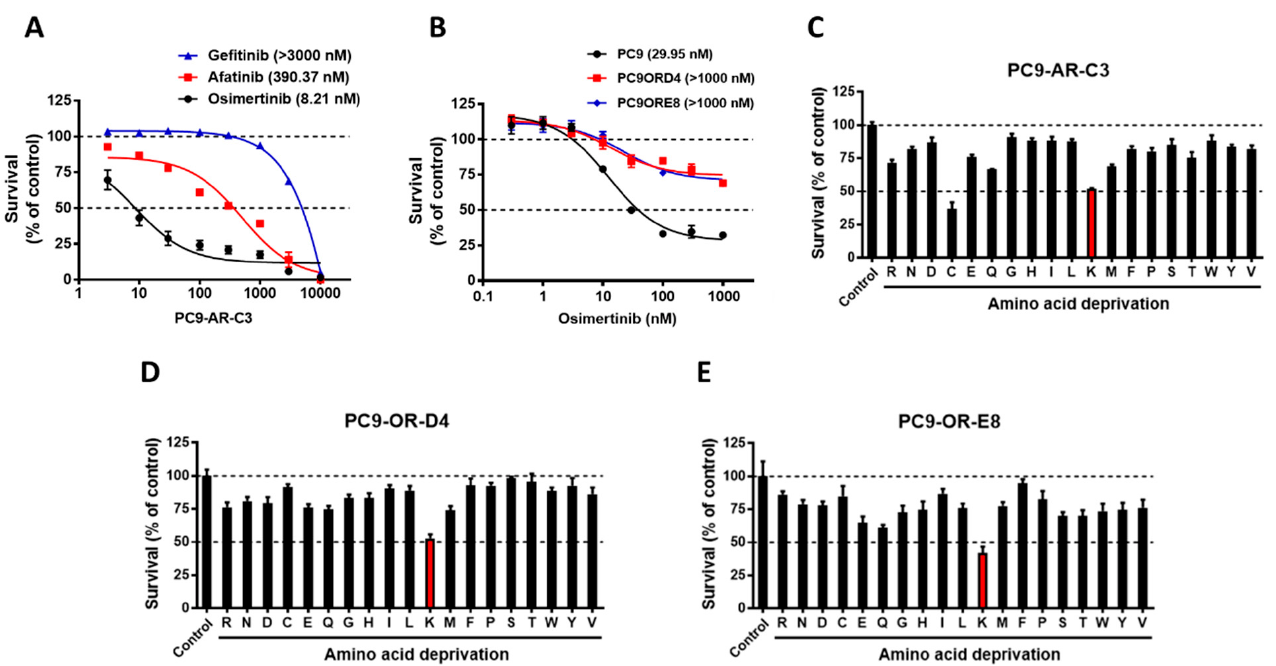
Figure 2. The EGFR-tyrosine kinase inhibitors (TKI)-resistant NSCLC cells were consistently sensitive to lysine deprivation. ( A ) The EGFR-TKI-resistant PC9 subline, PC9-AR-C3, was treated with various doses of gefitinib, afatinib, and osimertinib. Cell survival was analyzed using an SRB assay; ( B ) The parental PC9 cell lines and EGFR-TKI-resistant PC9 sublines, PC9-OR-D4 and PC9-OR-E8, were treated with several doses of osimertinib for 48 h. The survival of each cell line was analyzed using an SRB assay; ( C ) PC9-AR-C3, ( D ) PC9-OR-D4, and ( E ) PC9-OR-E8 cells were deprived of each amino acid for 48 h, and their survival was analyzed using an SRB assay (red bar: lysine deprivation). The results are representative data obtained from three independent experiments. OR, osimertinib-resistant cell line; AR, afatinib-resistant cell line; SRB, sulforhodamine